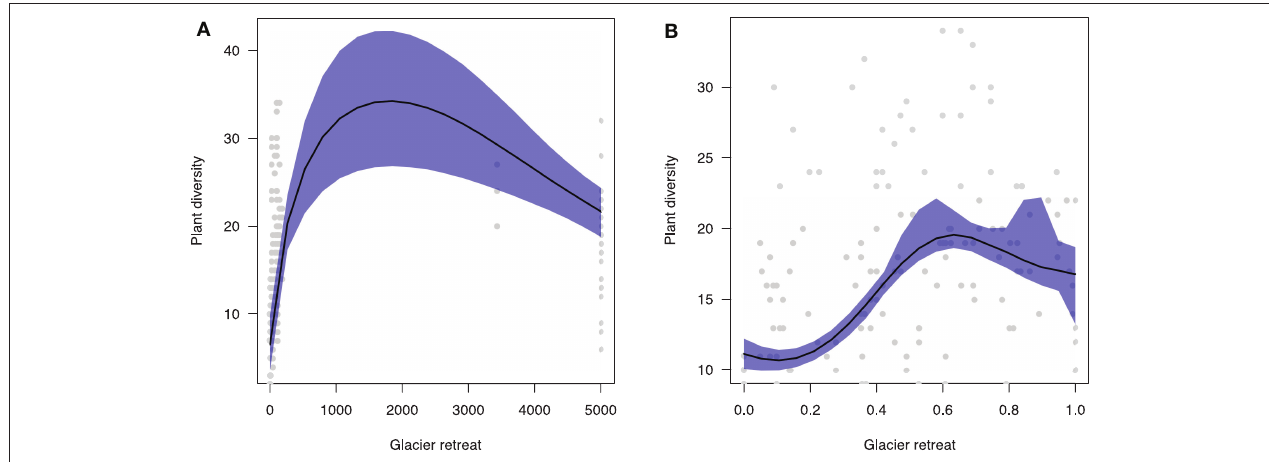
FIGURE 2 | Predicted effect of glacier retreat ( x -axis) on plant diversity ( y -axis). (A) Community age was estimated as the mean between two consecutive moraines. Notice that there is substantial geochronological uncertainty surrounding the age of communities beyond LIA moraines, since their age spans a range of 170–10,000 years (here, on average 5,000 years). (B) Community age was estimated as standardized differences in elevation along the glacier foreland transect.